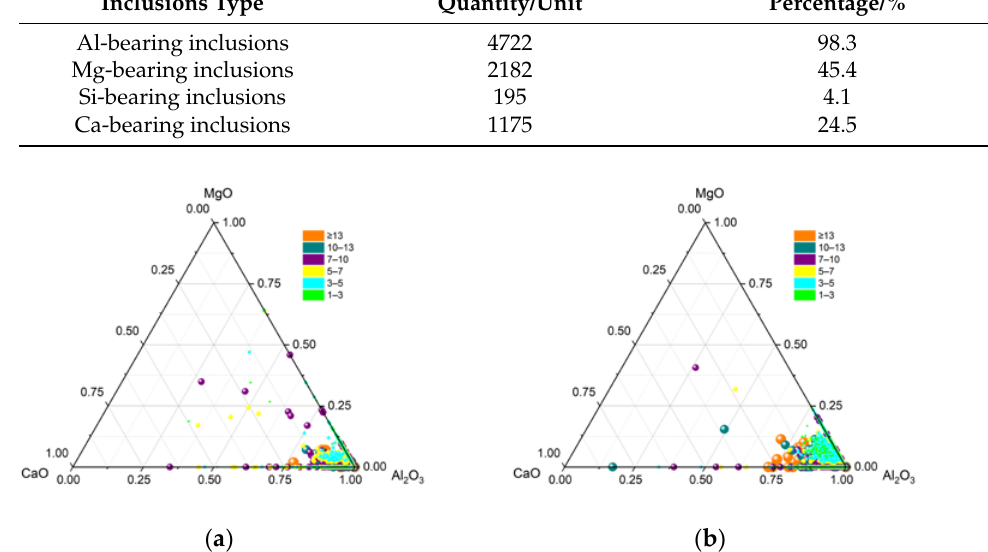
Figure 6. Composition and size distribution. Phase diagrams for inclusions in ( a ) Sample 1# and ( b ) Sample 2#.